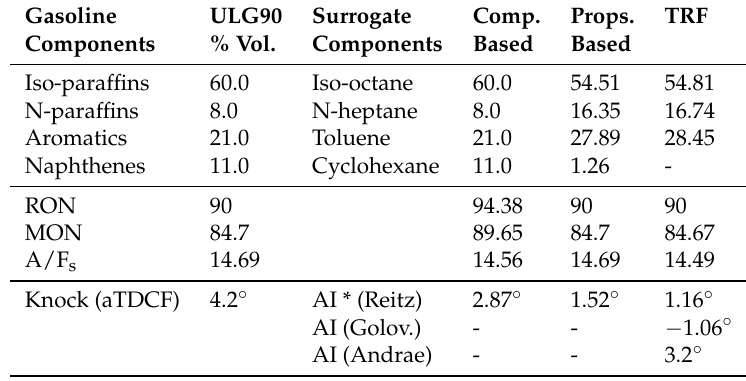
Gasoline ULG90 Surrogate Comp.